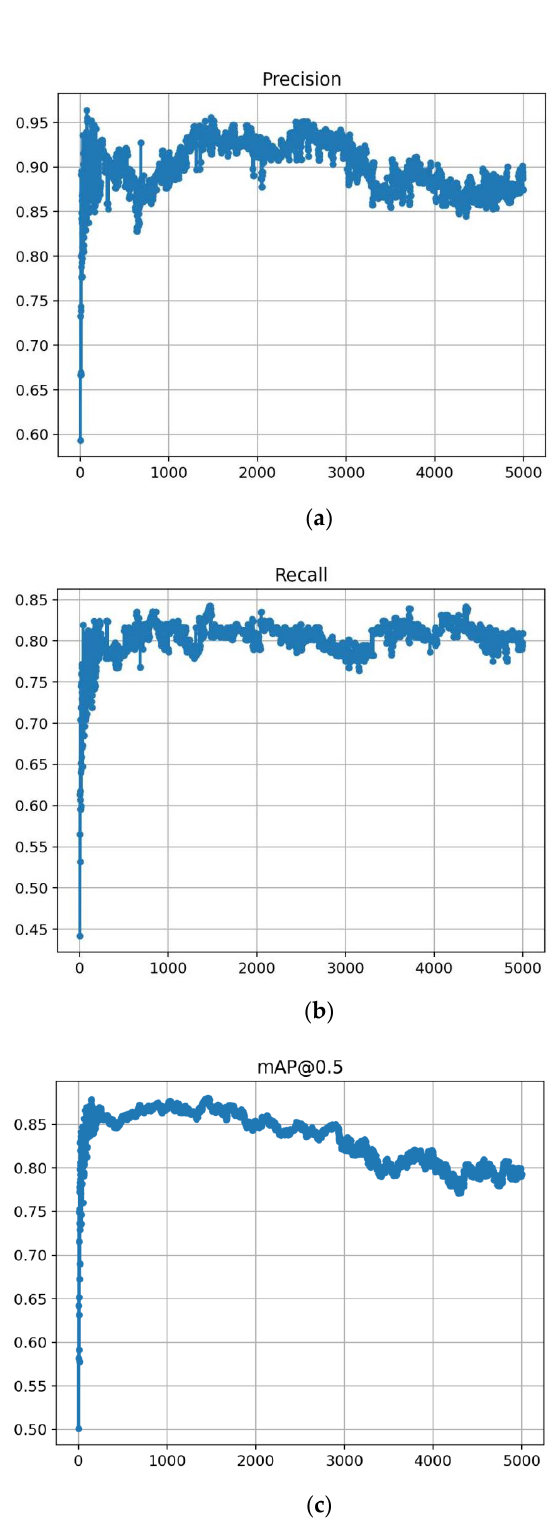
Figure 6. The training results of YOLOv5. ( a ) Precision. ( b ) Recall. ( c ) mAP.